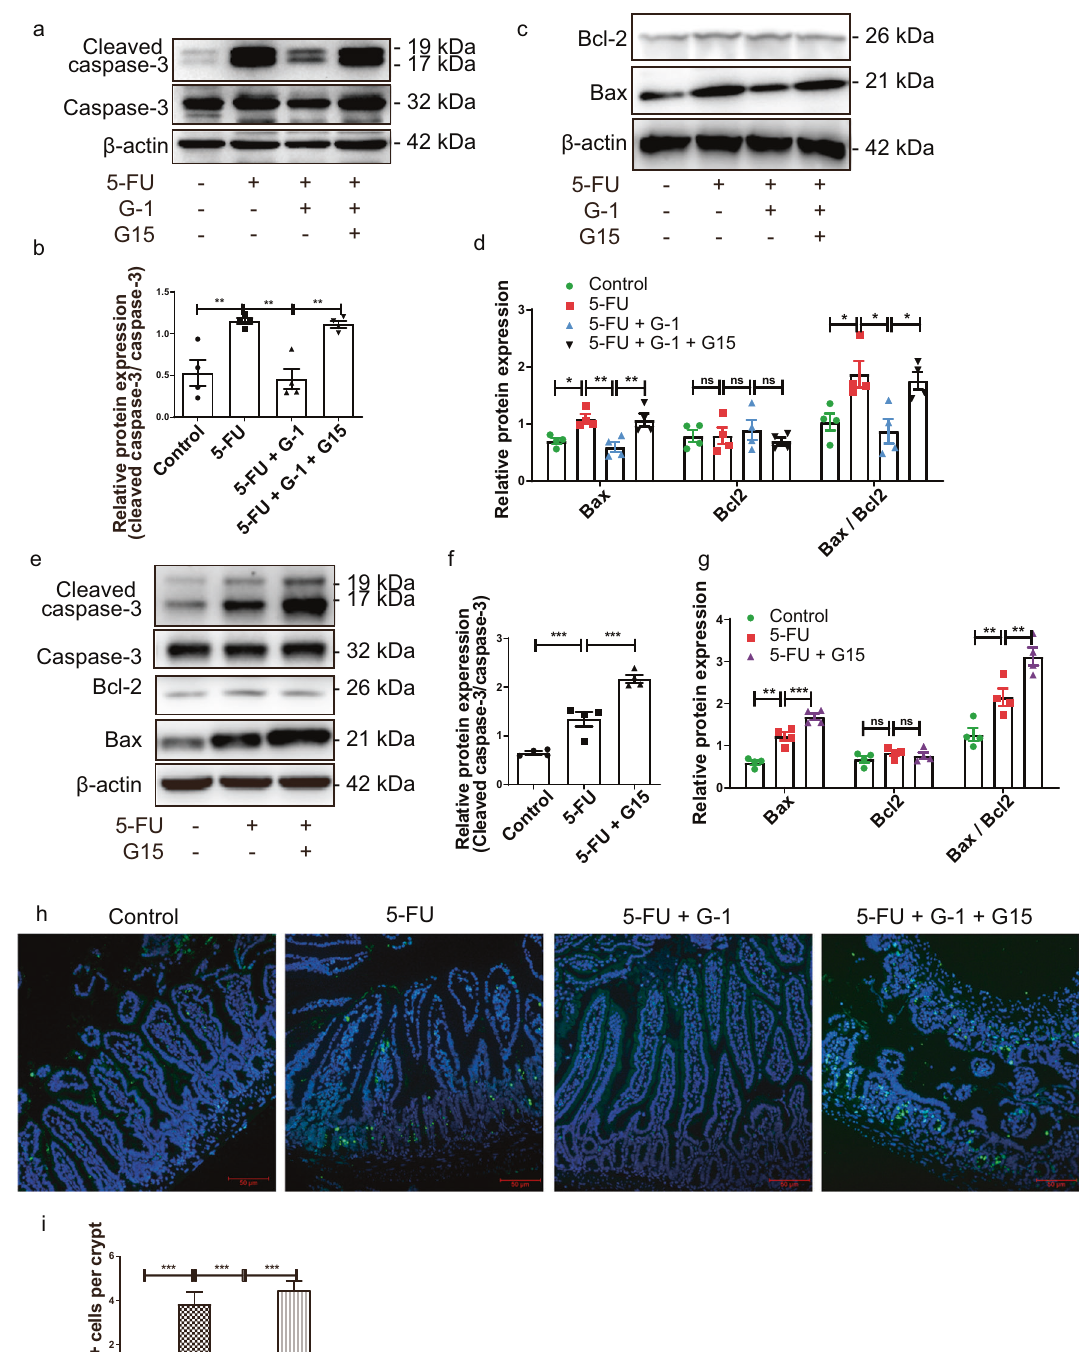
cells (cellular sources of the intestinal mucus barrier). ZO-1 distribution was disintegrated and partly absent after 5-FU treatment, and the expression of ZO-1 protein decreased. These abnormalities were reversed by G-1, G15 completely blocked the